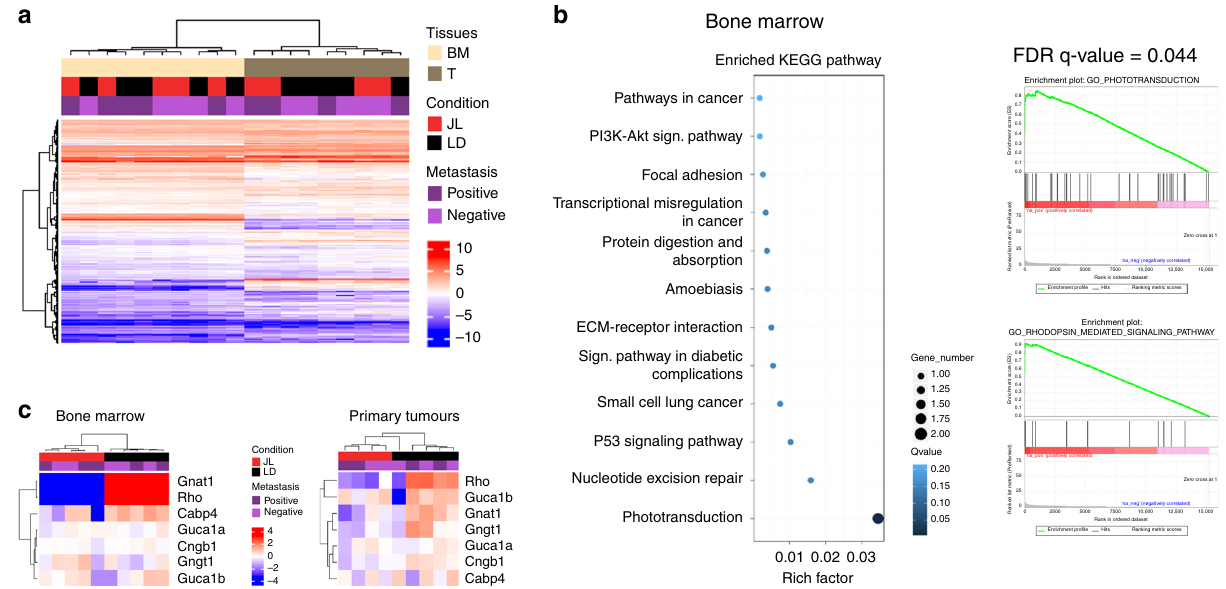
Fig. 3 Chronic circadian disruption does not profoundly alter gene expression pro fi les in primary tumours or bone marrow mononucleated cells, with the exception of genes linked with phototransduction and light perception. a RNA-seq sample heatmap and hierarchical clustering based on the expression (FPKM) of 12,556 genes across the two tissues. Gene expression matrix was centered, reduced, and log2 transformed. Samples appear as columns and genes as rows; samples are labelled by their tissue of origin (BM: bone marrow ( n = 10, salmon) and T: primary tumour ( n = 9, grey)), experimental conditions (JL ( n = 9) in red and LD ( n = 10) in black) and the presence ( n = 9)/absence ( n = 10) of metastasis (dark and light violet). Hierarchical clustering was performed using Euclidean distance and the Ward.D2 criterion for agglomeration. The colour scale represents expression levels, red for high expression and blue for low expression. b Enriched KEGG Pathway and Gene Set enrichment analysis for bone marrow. GSEA plots are shown for the Gene Ontology (GO) terms: Phototransduction and Rhodopsin_mediated_signaling_pathway. c Heatmap based on the expression (FPKM) of differentially expressed genes linked with phototransduction and photoperception in bone marrow ( n = 10) and primary tumours ( n = 9). Gene expression matrix was centered, reduced, and log2 transformed. Samples appear as columns and genes as rows; samples are labelled by the experimental conditions (JL in red and LD in black) and the presence/absence of metastasis. Hierarchical clustering was performed using Euclidean distance and the Ward.D2 criterion for agglomeration. The colour scale represents expression levels, red for high expression and blue for low expression. Indicated ( n ) represents the number of independent experiments as biological